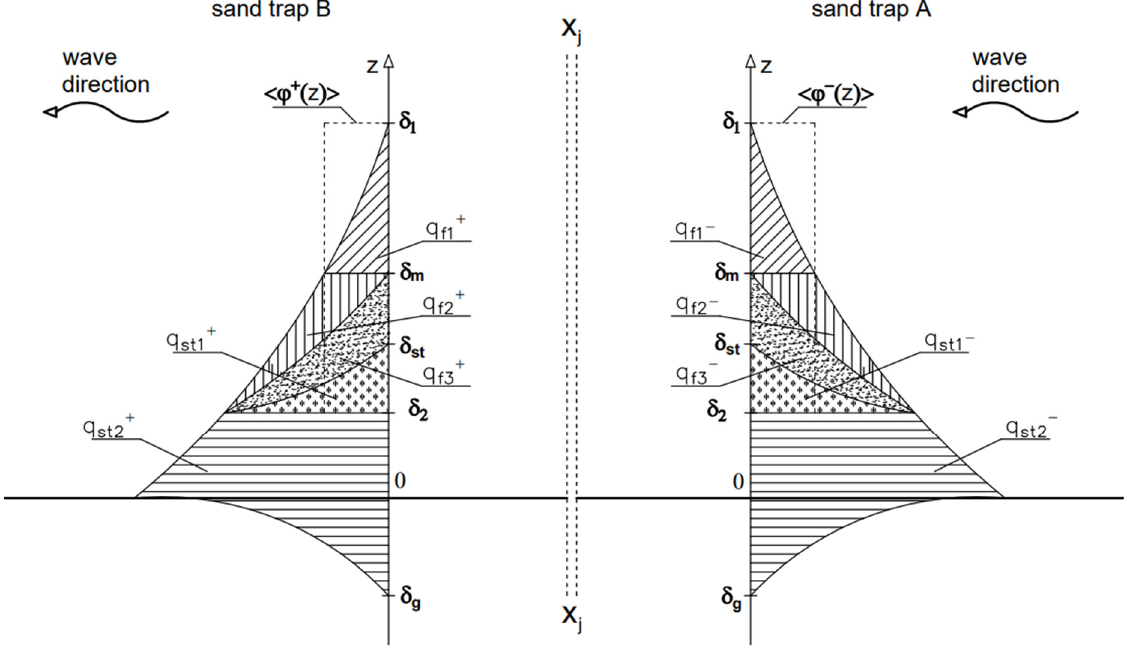
Figure 1. Vertical structure of the wave-induced progressive and reverse sediment